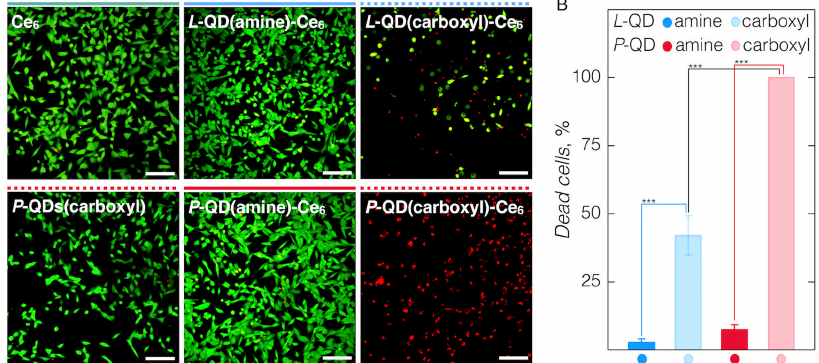
Figure 6. ( A ) Live (green)/Dead (red) images of cancer cells treated with different QD-Ce 6 complexes for 24 h and subjected to 470 nm irradiation at 17.7 J/cm 2 dosage. Images of the control experiments done with Ce 6 or P -QD(carboxyl) alone are also presented. Scale bars in all images are 100 µ m. ( B ) Respective percentages of dead cells in each studied case. Significant differences p < 0.0001 are indicated with